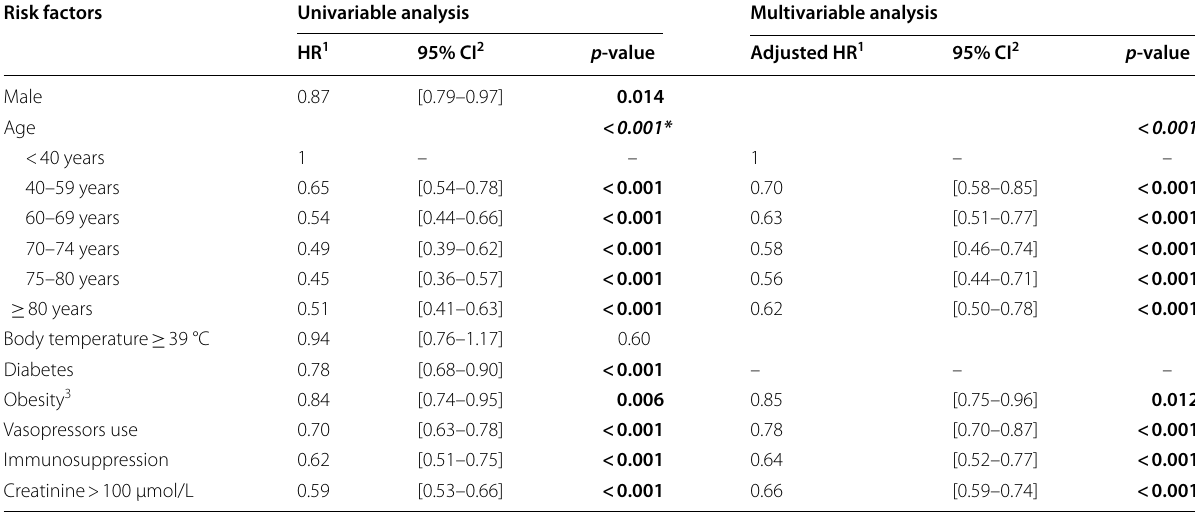
Table 2 Univariable and multivariable subdistribution hazard models for time to catheter removal for absence of further utility in the training cohort ( n 2336) =